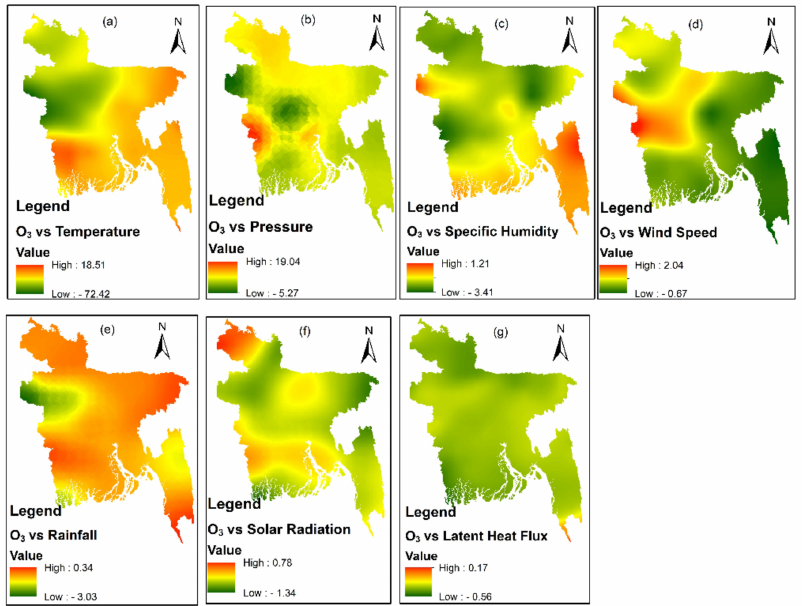
Figure 9. Spatial representation of the relationship between O 3 and meteorological variables using the geographically varying coefficients from GWR modelling over Bangladesh during 2015–2020: ( a ) temperature, ( b ) pressure, ( c ) specific humidity, ( d ) wind speed, ( e ) rainfall, ( f ) solar radiation, and ( g ) latent heat